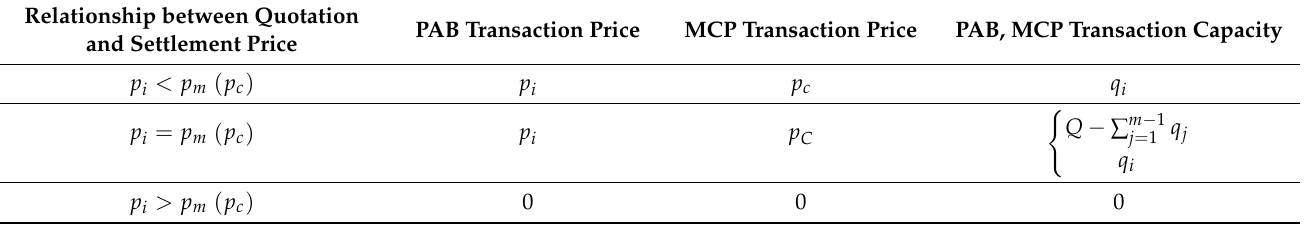
Table 2. Transaction price and transaction capacity of AGC units under PAB pricing mechanism and MCP pricing mechanism.